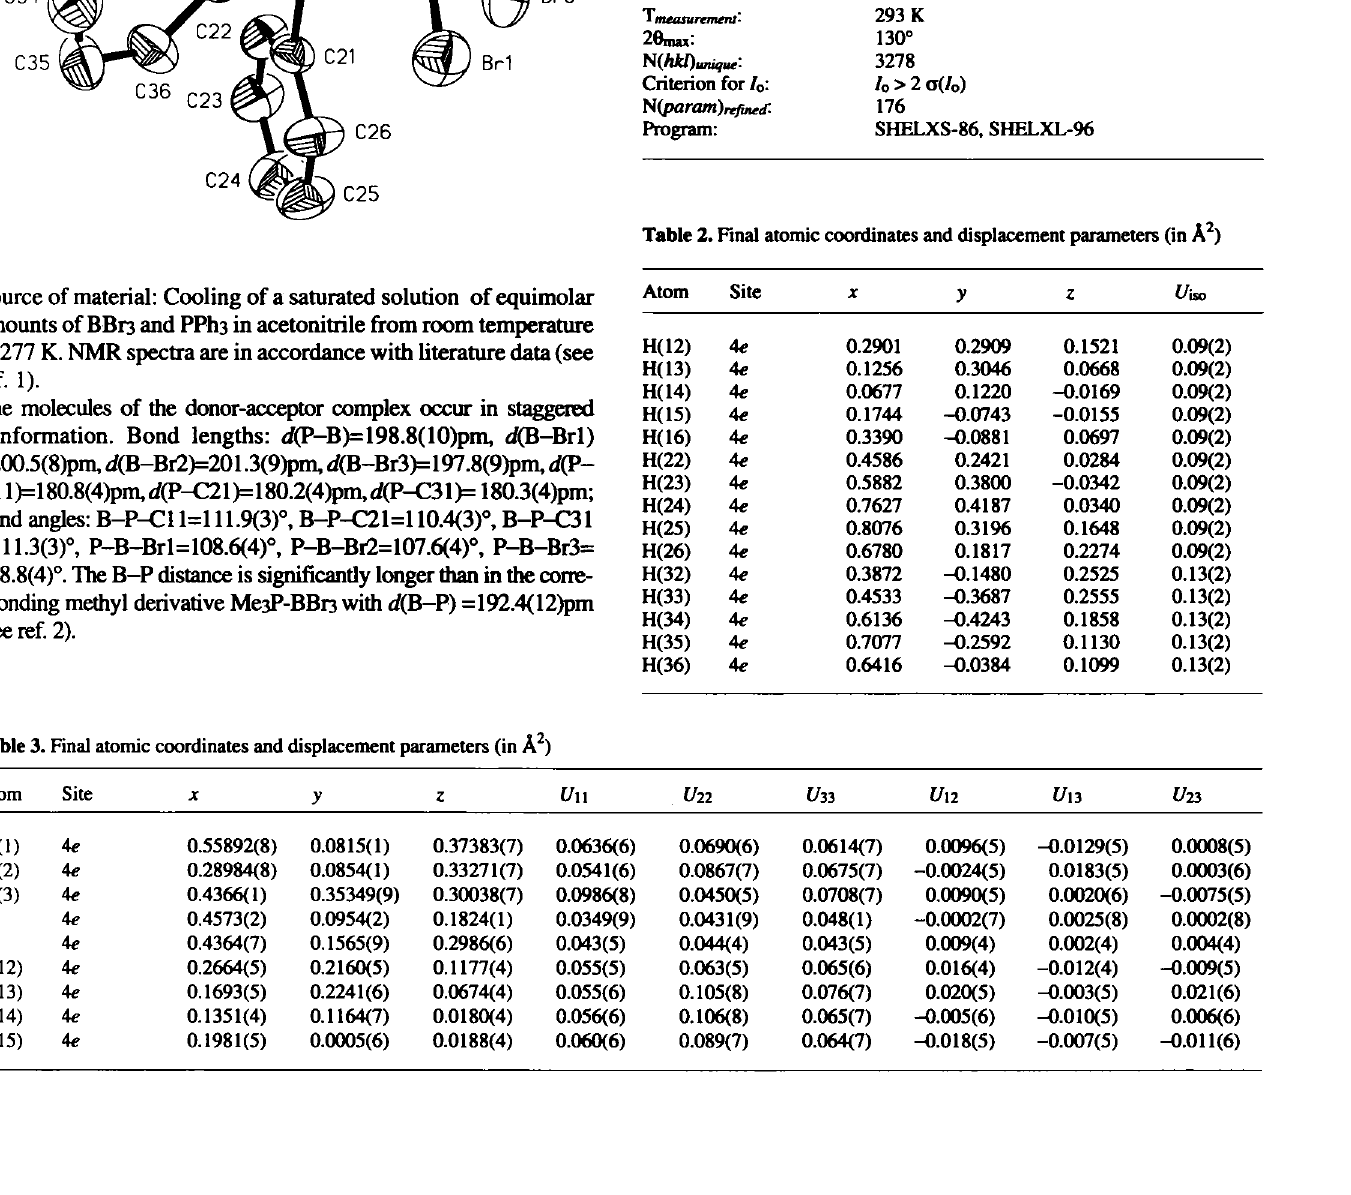
Table 1. Parameters used for the X-ray data collection Crystal: